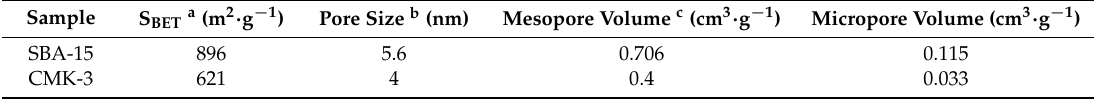
Table 2. Textural properties of SBA ‐ 15 and its CMK ‐ 3 replica.